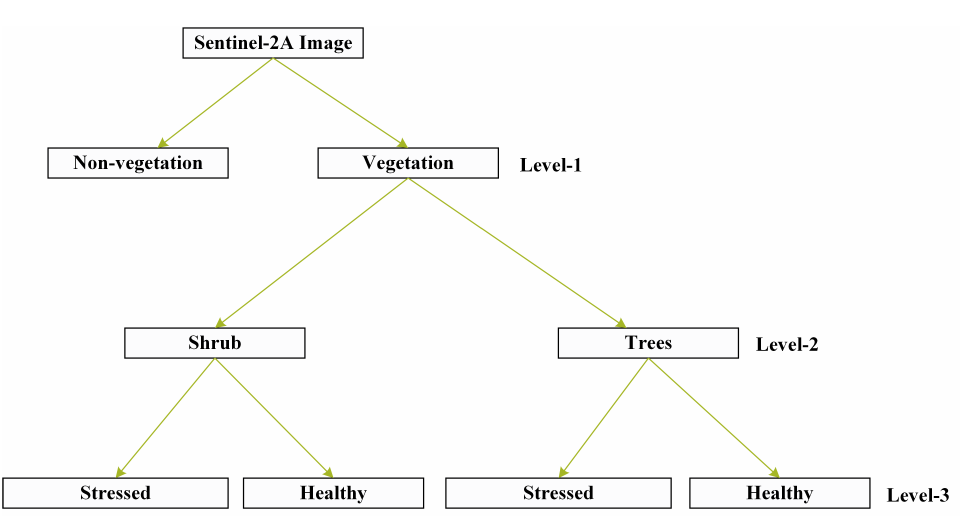
Figure 3. High level workflow of our method, which shows the hierarchical classification at three levels (Level-1, Level-2, Level-3) based on hard NDVI threshold ranges. Note that, in Level-1, we differentiate regions into Non-vegetation and Vegetation regions. Similarly, in Level-2, we differentiate regions into Shrub and Trees regions. Finally, in Level-3, both Shrub and Trees regions are differentiated into Stressed and Healthy regions